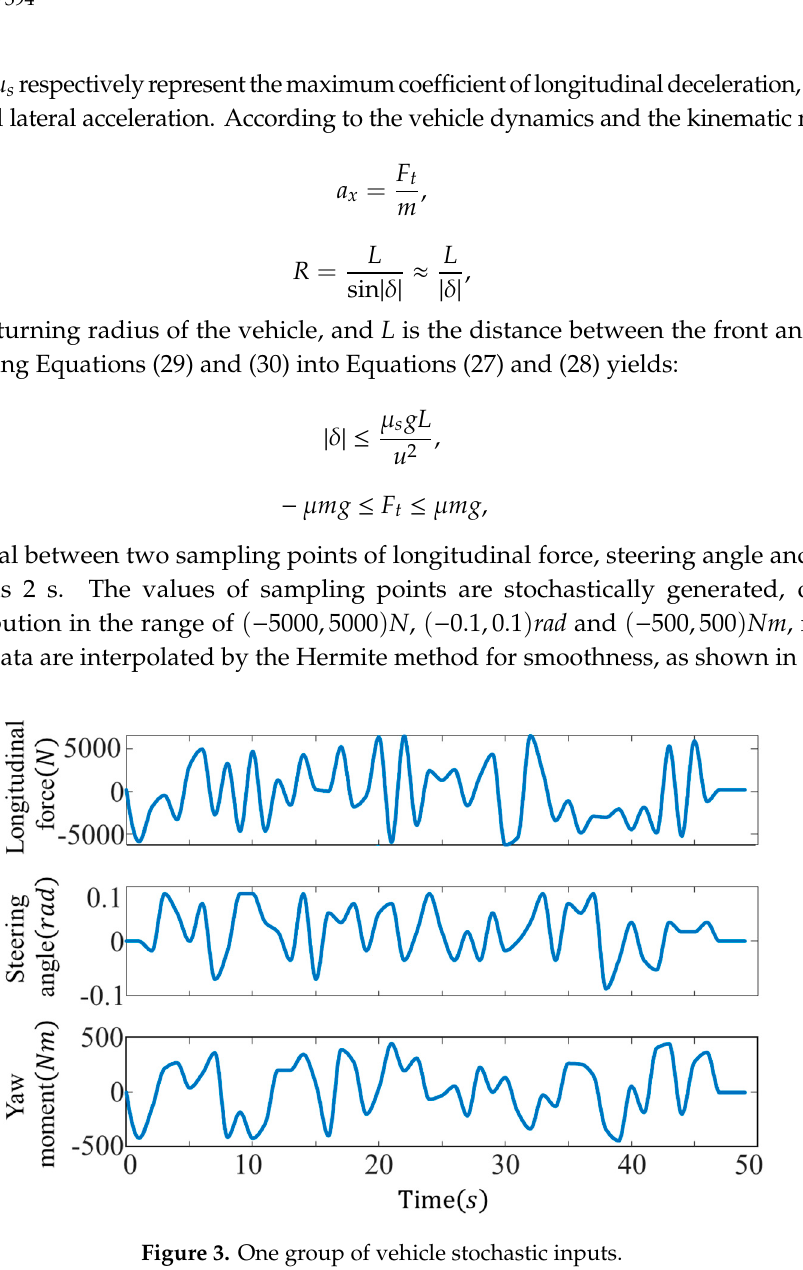
Figure 3. One group of vehicle stochastic inputs.